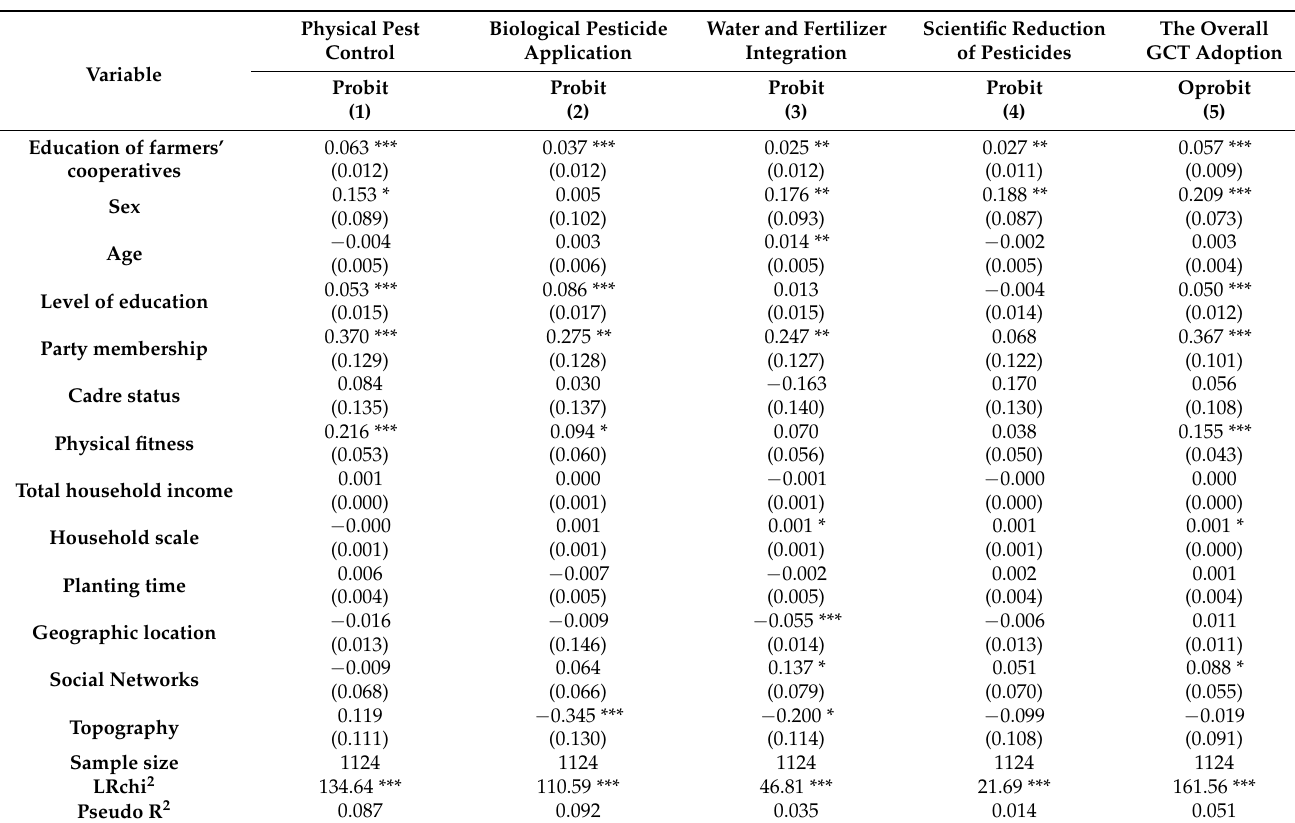
Table 4. Estimated impact of cooperative’s education on GCT